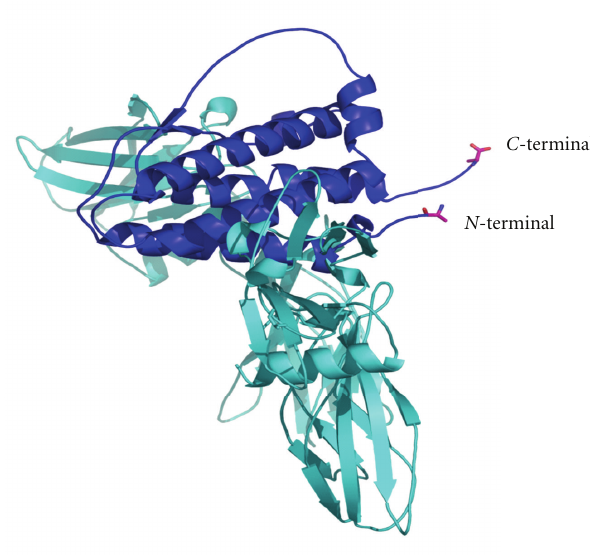
Figure 2: Model of erythropoietin binding to its receptor. The diagram showing the complex of EPO bound to the receptor. Note that the N -terminal and C -terminal of EPO are free and not involved in the binding